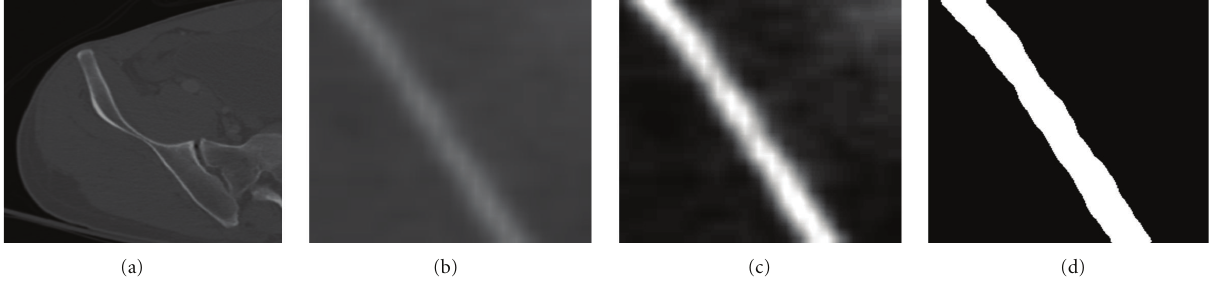
Figure 9: Example of a detected nonbroken boundary of pelvic bone, which may indicate no fracture.